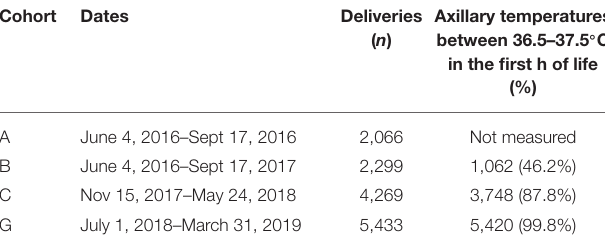
TABLE 4 | Rate of axillary temperature in the normal range (36.5–37.5 ◦ C) after the implementation of the NALS service. Cohort